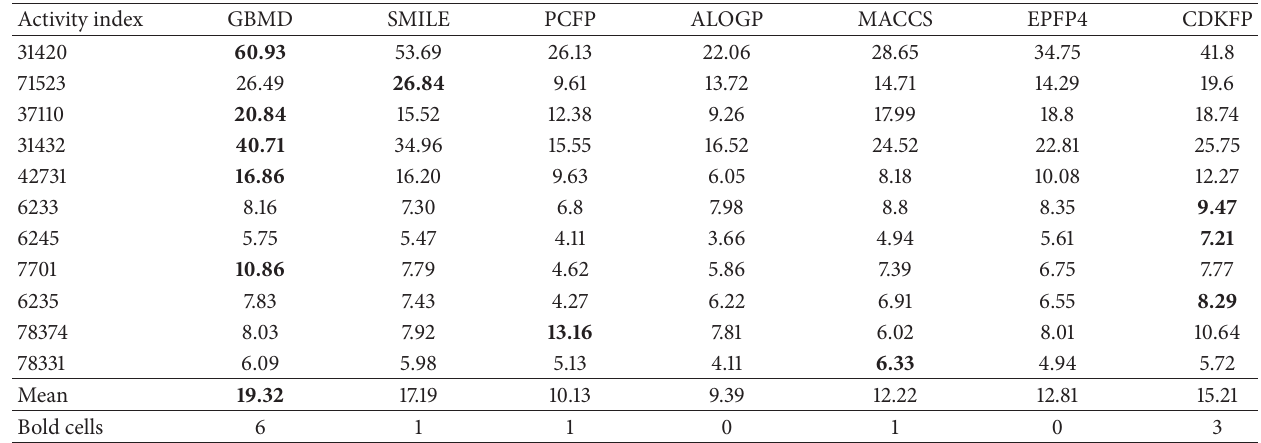
Table 4: Retrieval results of top 1% for data set